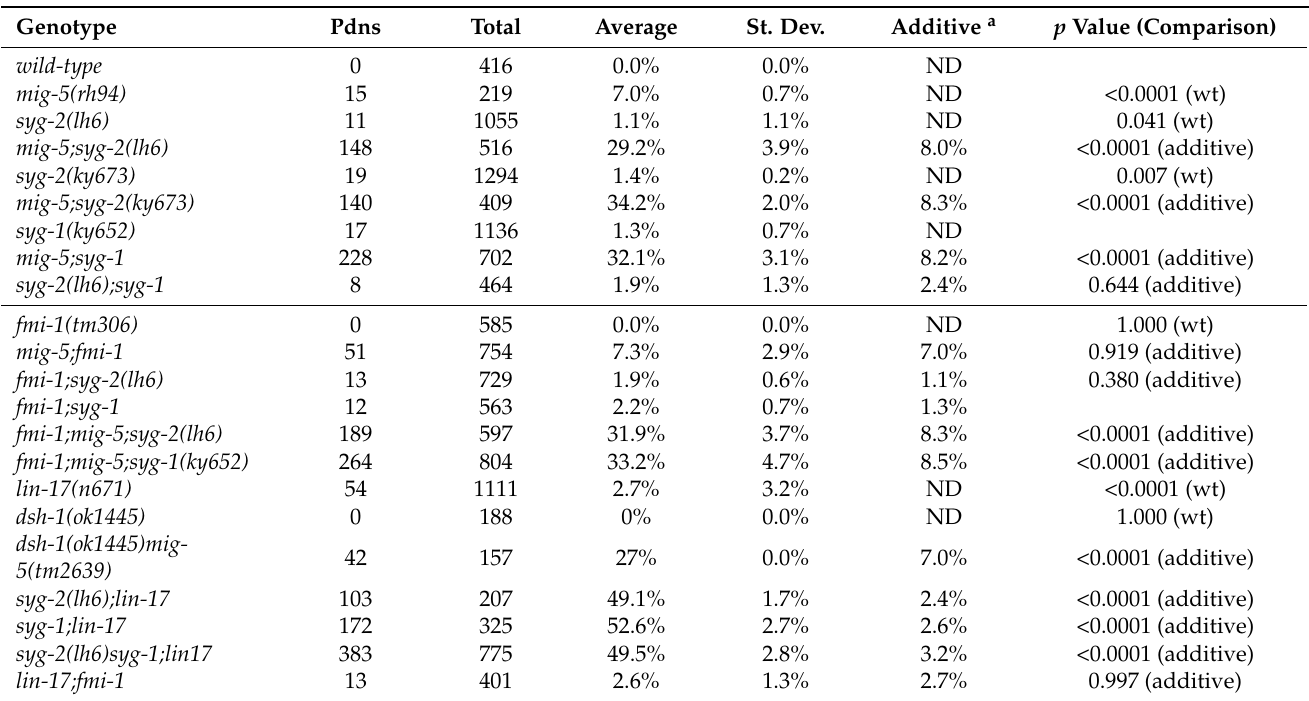
Table 2. Pdns observed in L1s